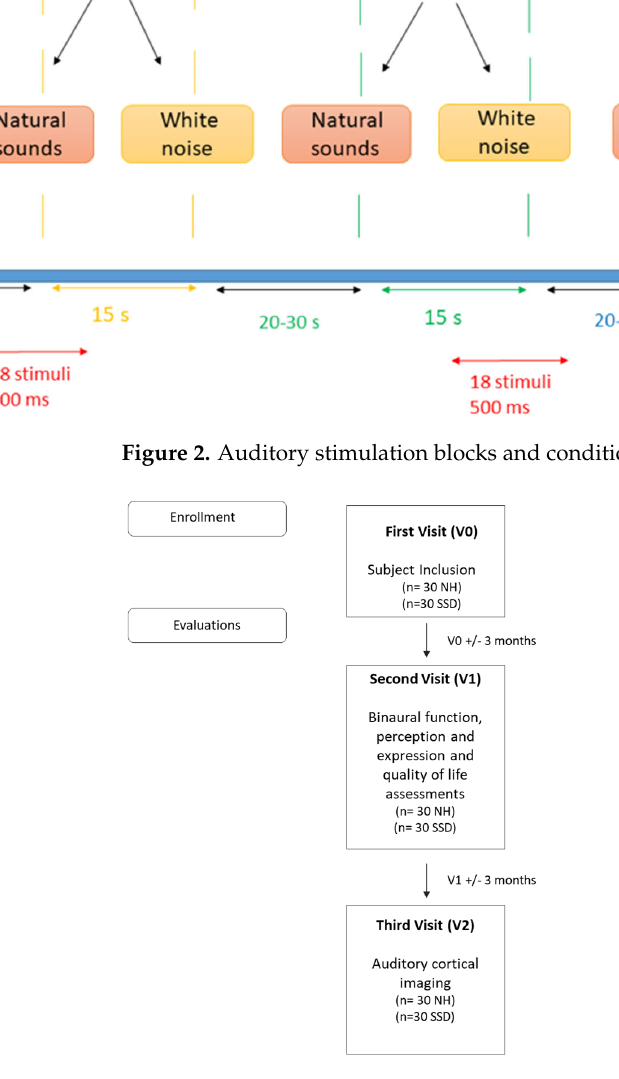
Figure 3. The timeline of procedures during the study.